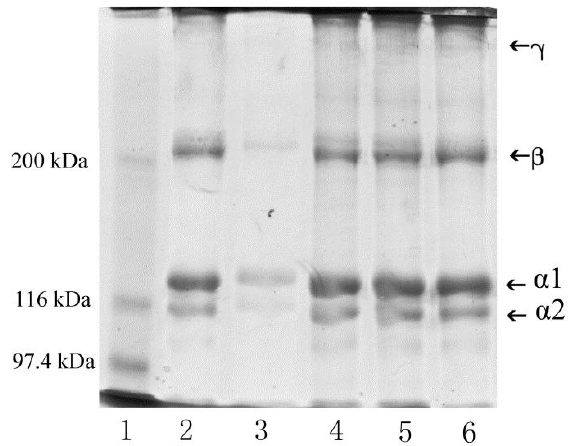
Figure 5. SDS-PAGE patterns of native collagen and collagens modified by the SiO 2 /DAC hybrid materials: ( lane 1 ) protein markers; ( lane 2 ) native collagen; ( lane 3 ) collagen modified by DAC; ( lane 4 ) collagen modified by SiO 2 /DAC (1/10); ( lane 5 ) collagen modified by SiO 2 /DAC (1/2); ( lane 6 ) collagen modified by SiO 2 .